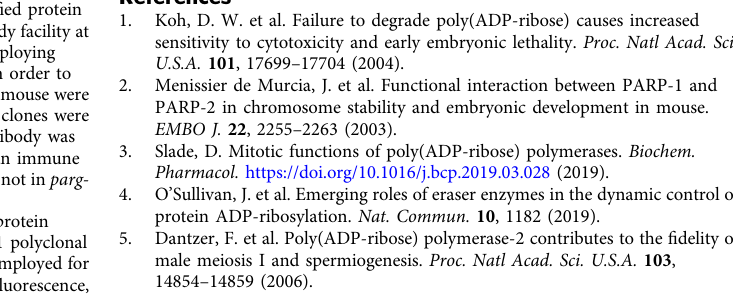
Fig. 5 refer to the total number of worms analysed in independent replicates. Statistical analysis of the differences in the recombination rate for each genetic interval between the mutant backgrounds and the controls is reported in the Supplementary Table